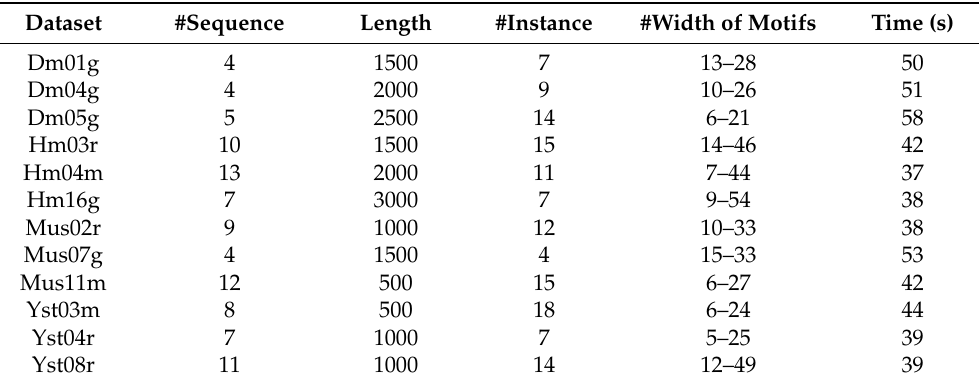
Table 3. The properties of the benchmark datasets.